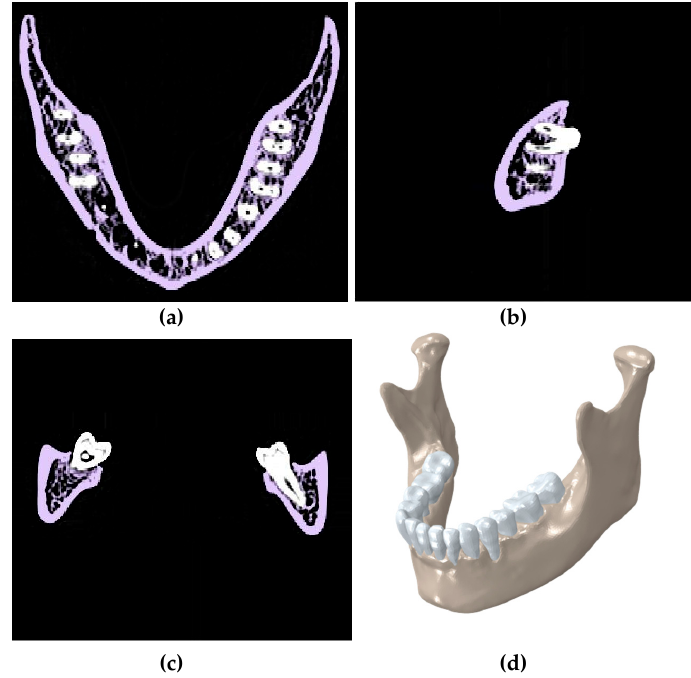
Figure 1. Segmentation of CT scan of a healthy mandible showing the ( a ) transverse plane; ( b ) sagittal plane; and ( c ) coronal plane; ( d ) a 3D model in Mimics.